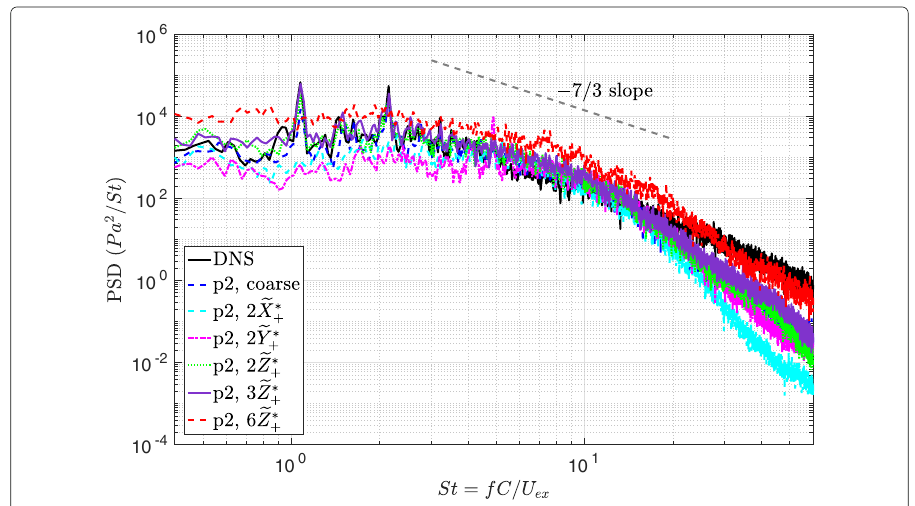
Fig. 14 Comparison of the PSD of pressure at wake point(2) for the coarse LES